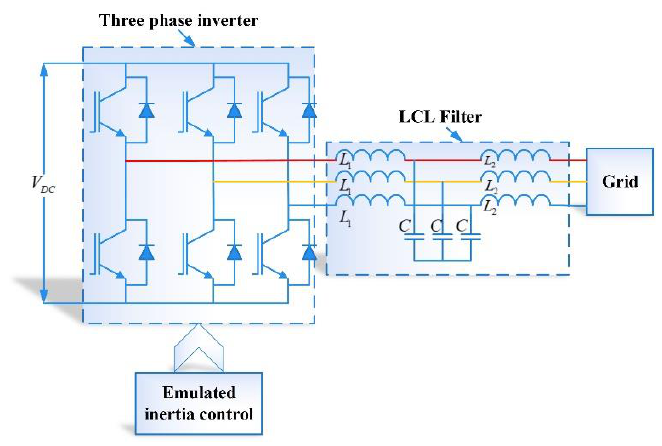
Figure 4. Three-phase inverter with LCL